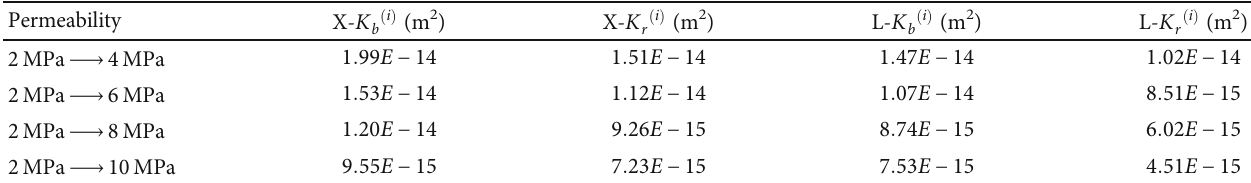
Table 8: The permeability evolution during the loading-unloading process with the axial strain 1.79%. Permeability